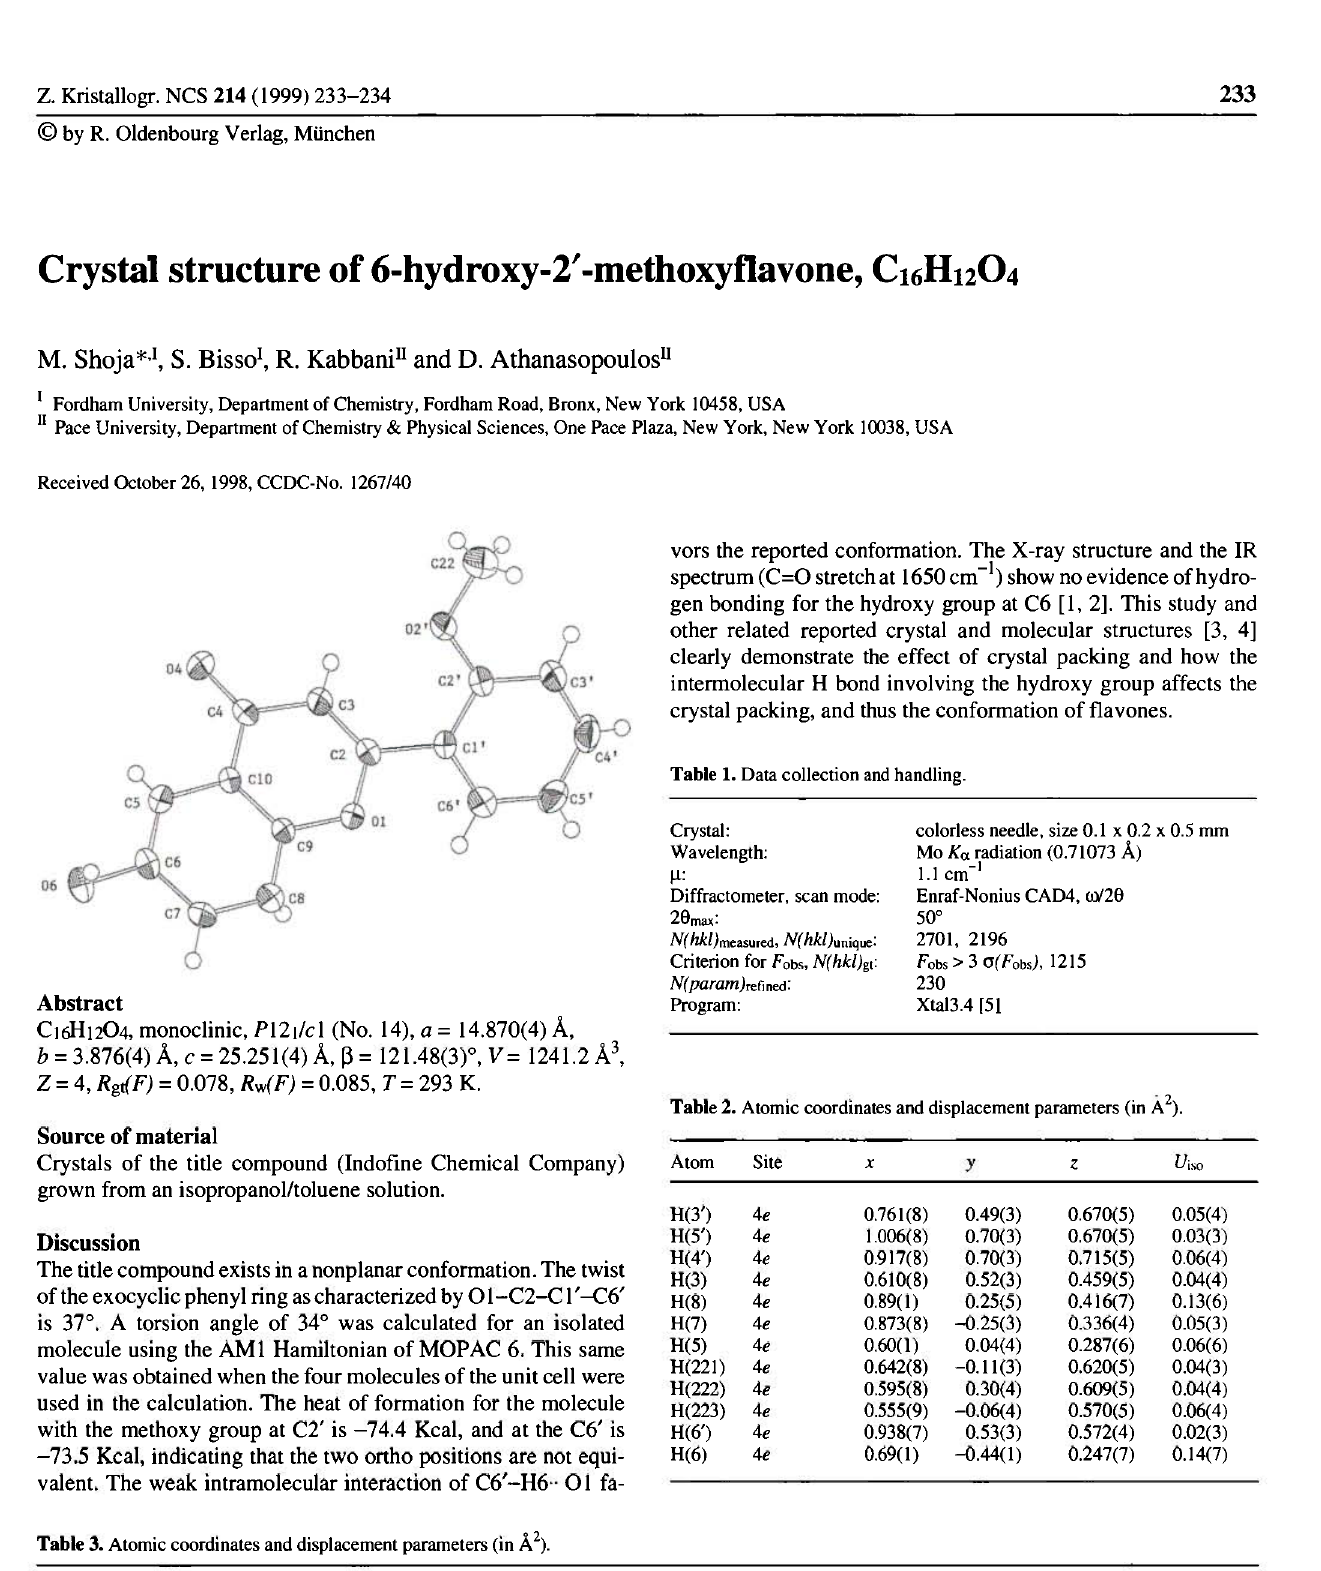
Table 3. Atomic coordinates and displacement parameters (in Ä 2 ).